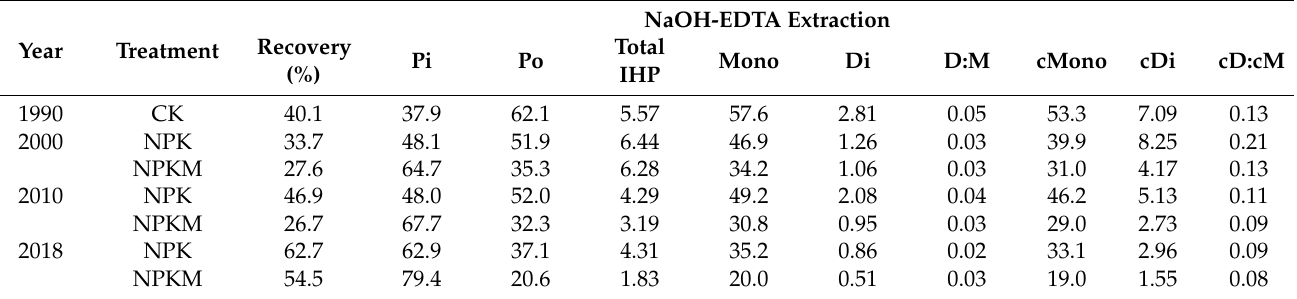
Table 3. The proportion of P fraction with NaOH-EDTA extractions of the studied soil under long- term field trial in